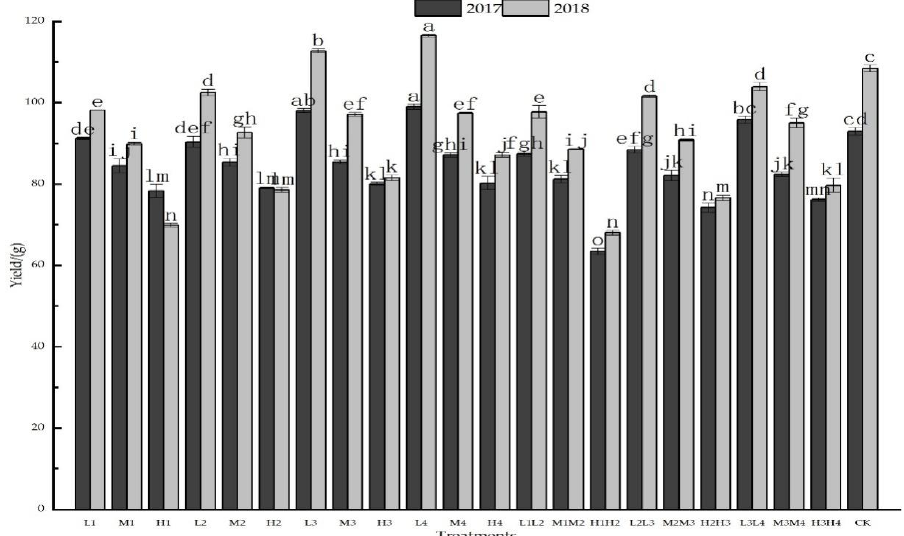
Figure 2. Yields of different treatments in 2017 and 2018. Different lowercase letters represent different levels of each column at p ≤ 0.05. L: light drought stress, M: medium drought stress, H: severe drought stress. The number “1”, “2”, “3” and “4” represent the tillering, jointing and booting, flowering, and milk ripening stages, respectively.